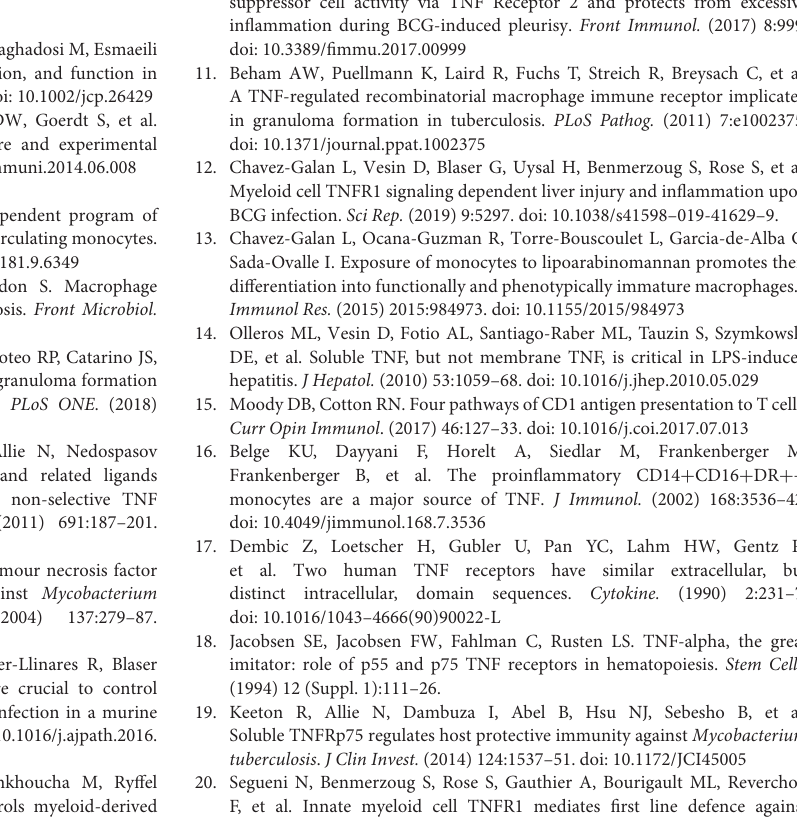
Figure S1 | Differentiation process to obtain monocyte-derived-macrophages (MDM). (A) CD14 + monocytes were enriched by magnetic beads-labeled antibodies; representative histograms show the purity percentage (left) and verification of absence of exclude lymphoid cells in our culture (right). (B) After 7 days in culture, MDM morphology was confirmed by microscopy using a magnification 20X (left) and 100X (right, scale bar 10 µ m). (C) Representative zebra plot and histogram of MDM where the expression of CD68, CD14, HLA-DR, CD11b, CD80, and CD86 were measured by flow cytometry. (D) Representative zebra plot to evaluate the expression of TCR αβ and γδ chains inside the CD3 − gated cells. The data are representative of at least 12 independent donors. Figure S2 | High quality of RNA to develop qPCR for each MDM subpopulation, before and after FACS sorting. Human MDM subpopulations were sorted by flow